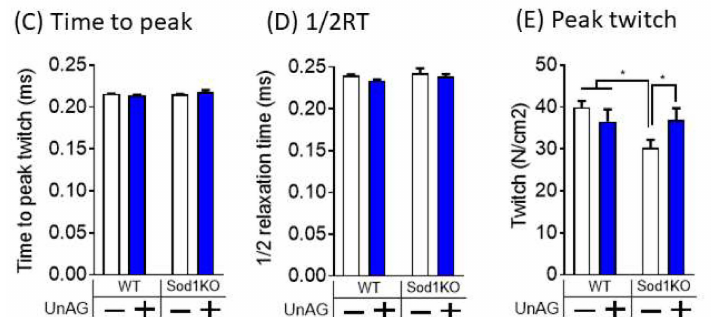
Figure 5. Unacylated ghrelin improves contractile properties of EDL muscle. ( A ) Isometric maximum specific force, force per cross-sectional area, were significantly decreased in Sod1KO, but fully protected by unacylated ghrelin treatment. ( B ) Maximum absolute force generation is significantly lower in Sod1KO mice, but partially protected by unacylated ghrelin. ( C ) Time to reach peak twitch is unchanged by Sod1KO or unacylated ghrelin treatment. ( D ) Half relaxation time (1/2 RT) did not differ by Sod1 deletion or unacylated ghrelin. ( E ) Peak twitch is significantly reduced in Sod1KO but preserved by unacylated ghrelin treatment. Two-Way ANOVAs were used to test statistical significance between groups, followed by Tukey post hoc tests. Data are mean ± SEM. * p < 0.05.